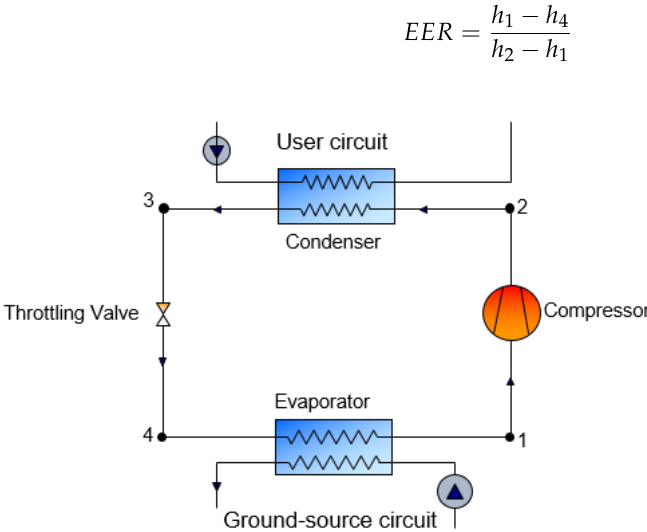
Figure 3. Basic thermodynamic cycle for heat pump.